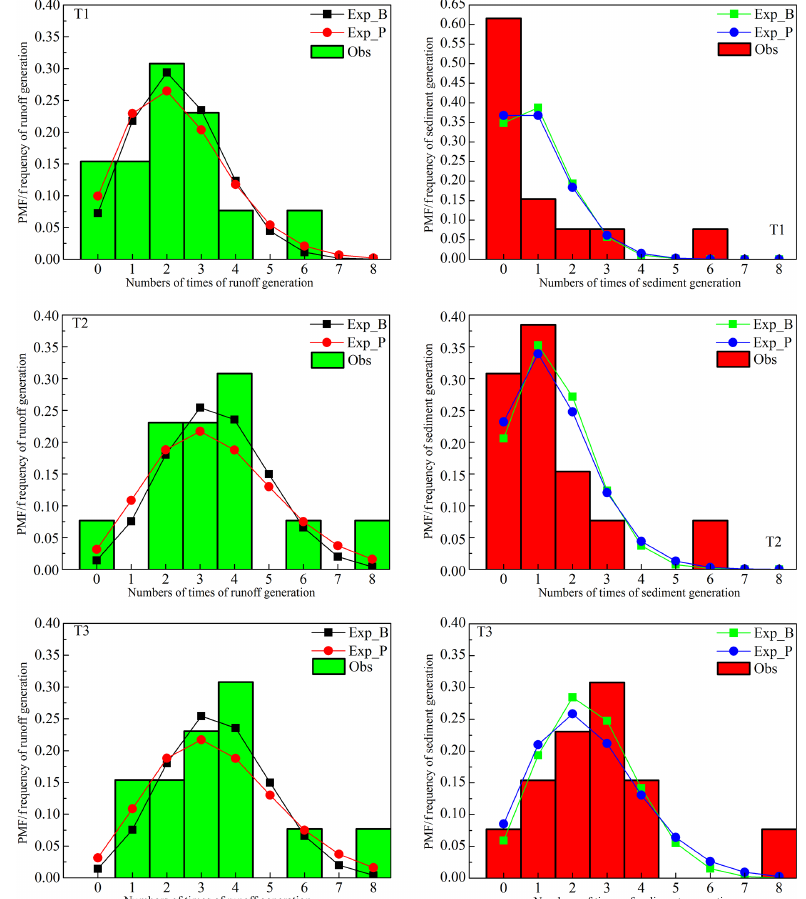
Figure 5. The comparison between simulation of stochasticity of runoff and sediment events by binomial and Poisson PMFs and the observed frequencies of numbers of times of soil erosion events in three restoration vegetation types; Exp_B and Exp_P indicate the simulated values in binomial and Poisson PMF respectively; the histogram shows the observed